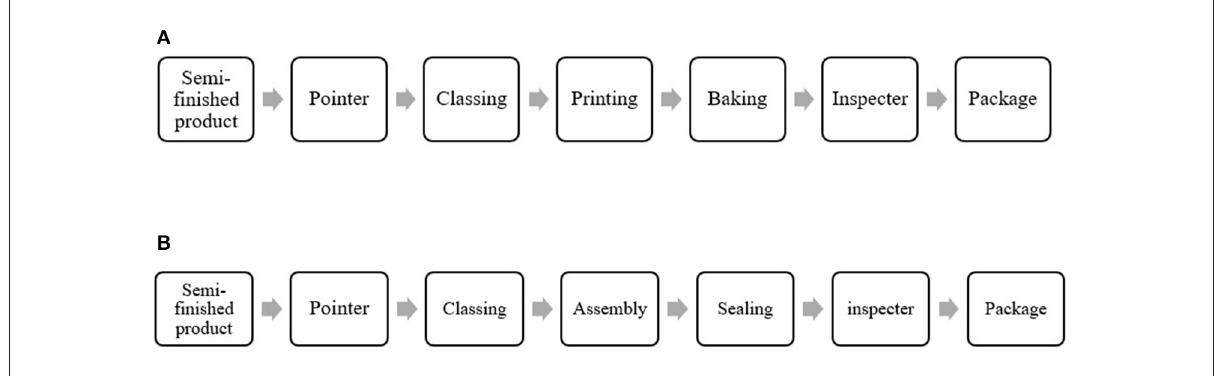
FIGURE1 Main technological process of the thermometer manufacturing enterprise: (A) Trigonal thermometer, (B) Internal scaling thermometer.